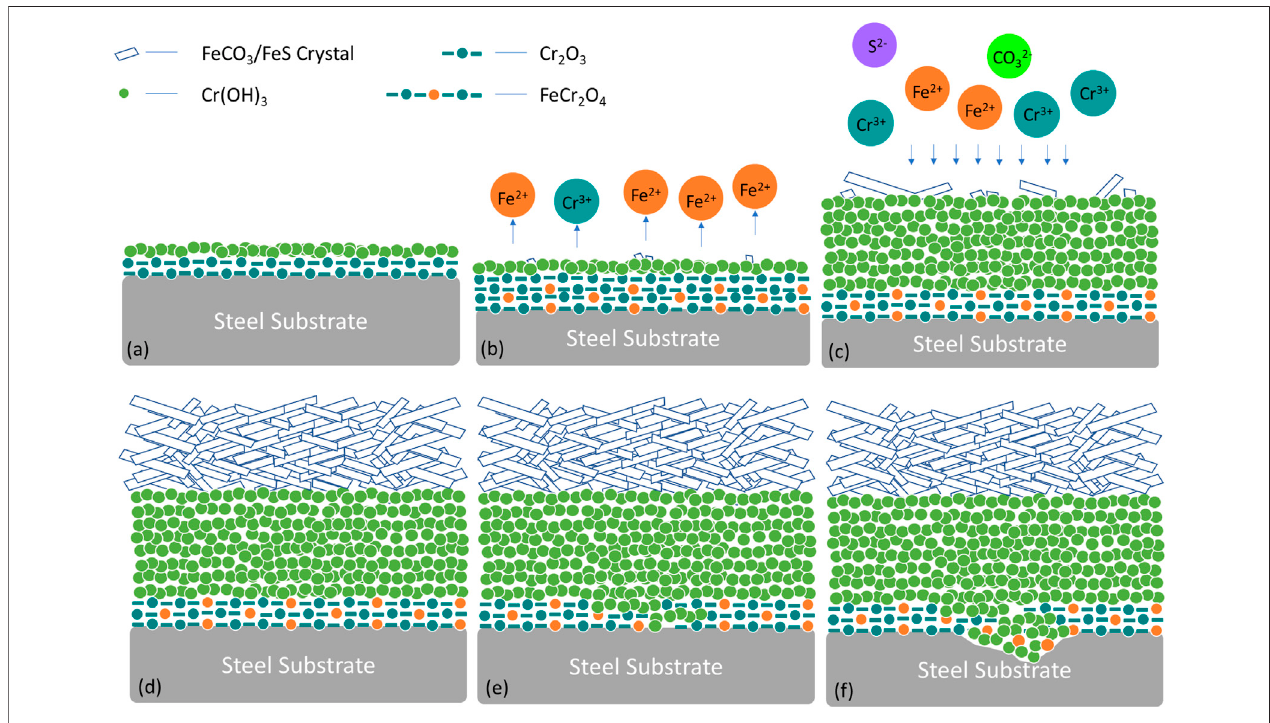
FIGURE 13 | Schematic diagram of (A – D) the sequence of the formation of the outer and inner layers of the double-layered corrosion products and (E – F) the development of localized corrosion in CO 2 -saturated formate solution at 180 ° C.